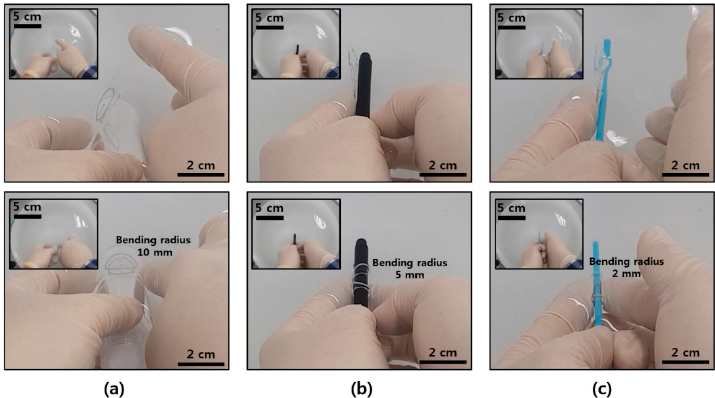
Figure 5. Photographs of the setup for mechanical bending tests. All tests proceeded inside saline